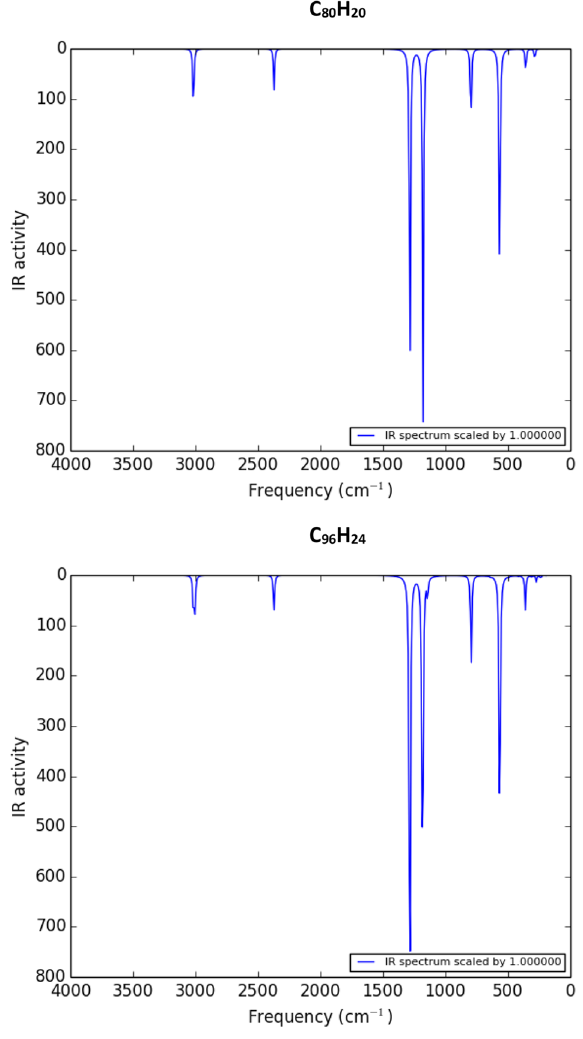
Figure 2. The infrared spectra for the fullerynes, C 80 H 20 and C 96 H 24